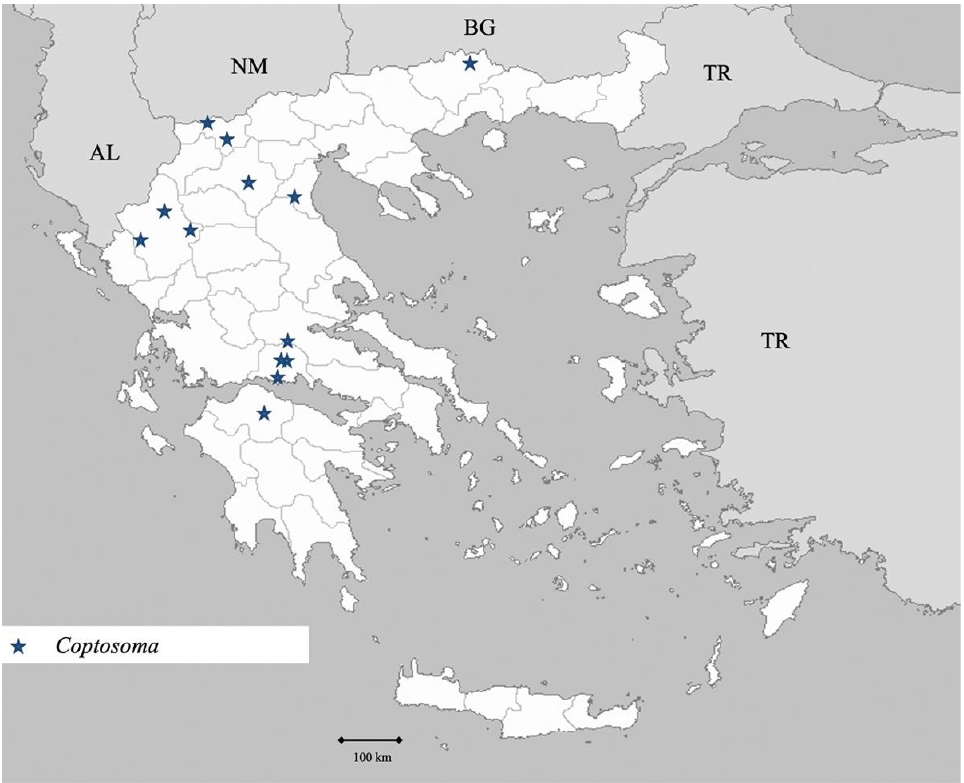
Figure 20. Map showing collecting sites of species of genus Coptosoma during the present study in Greece.